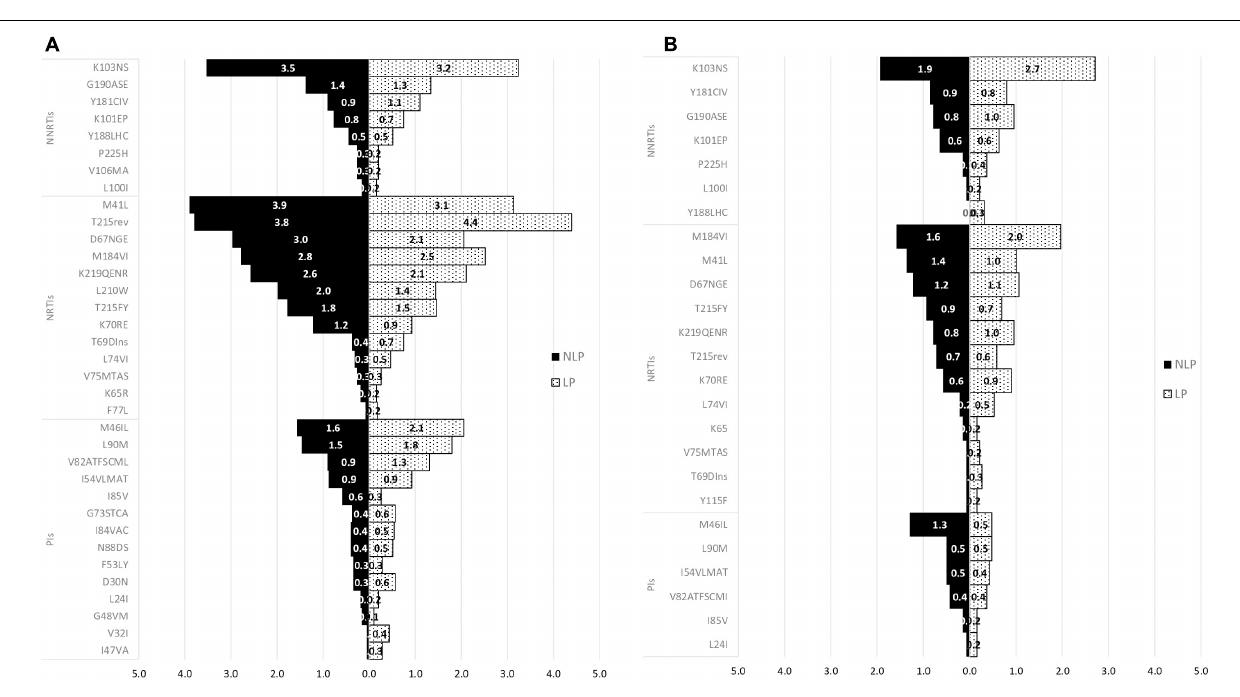
with higher prevalence for NNRTIs (3.5% for NLP and